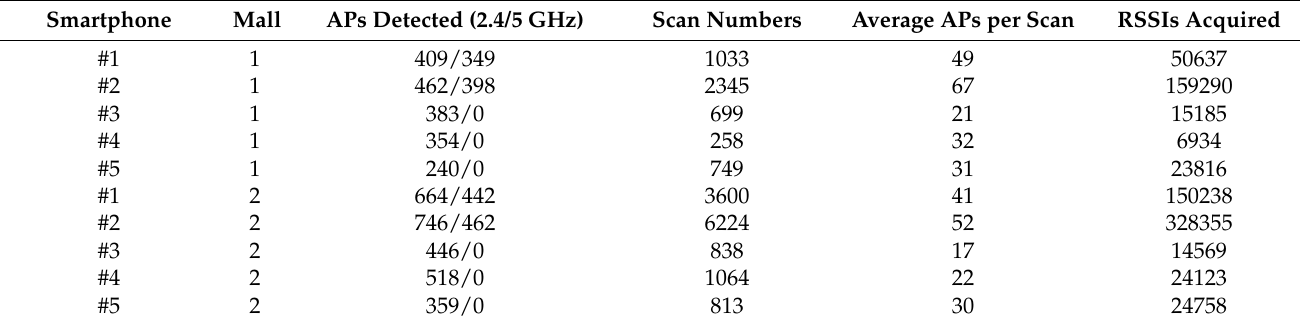
Table 4. Offline calibration phase: summary of the fingerprints acquired in both malls using the five different smartphones.